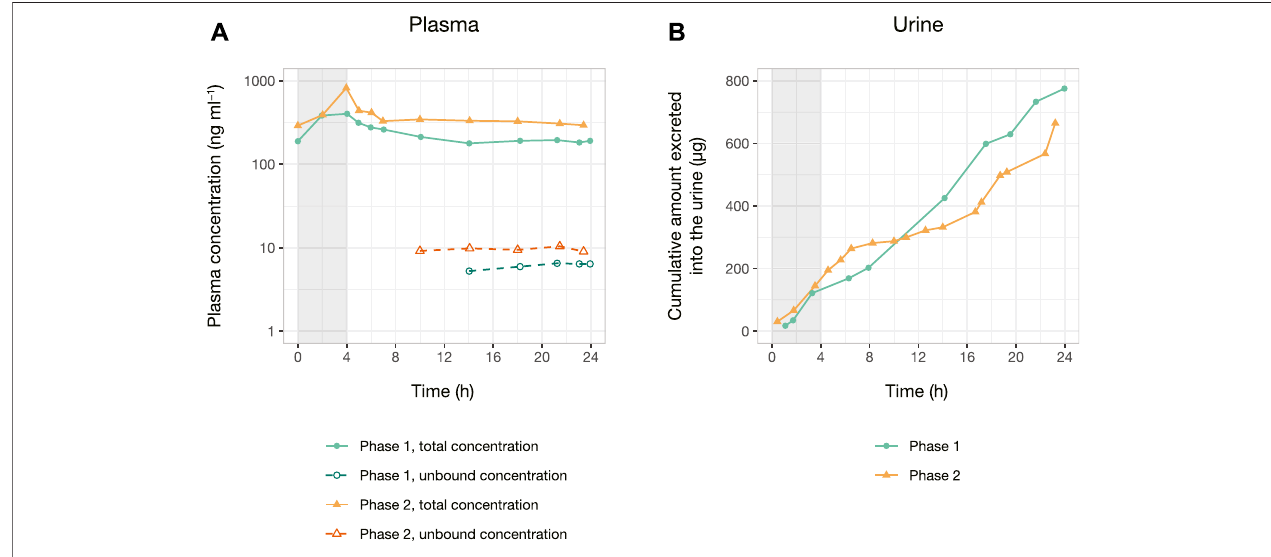
FIGURE 4 | Pharmacokinetics data of a patient treated for neurocryptococcosis with 100 mg of amphotericin B lipid complex as a 4 h i. v. infusion. Total and unboundplasmaconcentrationversustimecurve (A) ispresentedinng ml − 1 ,andthecumulativeamountexcretedintotheurineversustimecurve (B) ispresentedin μ g. Phase 1 was conducted on the 4th day of administration of amphotericin B, whereas phase 2 was conducted on the 16th day of treatment with the drug. The gray area indicates the length of the i. v. infusion (4 h) in both phases.